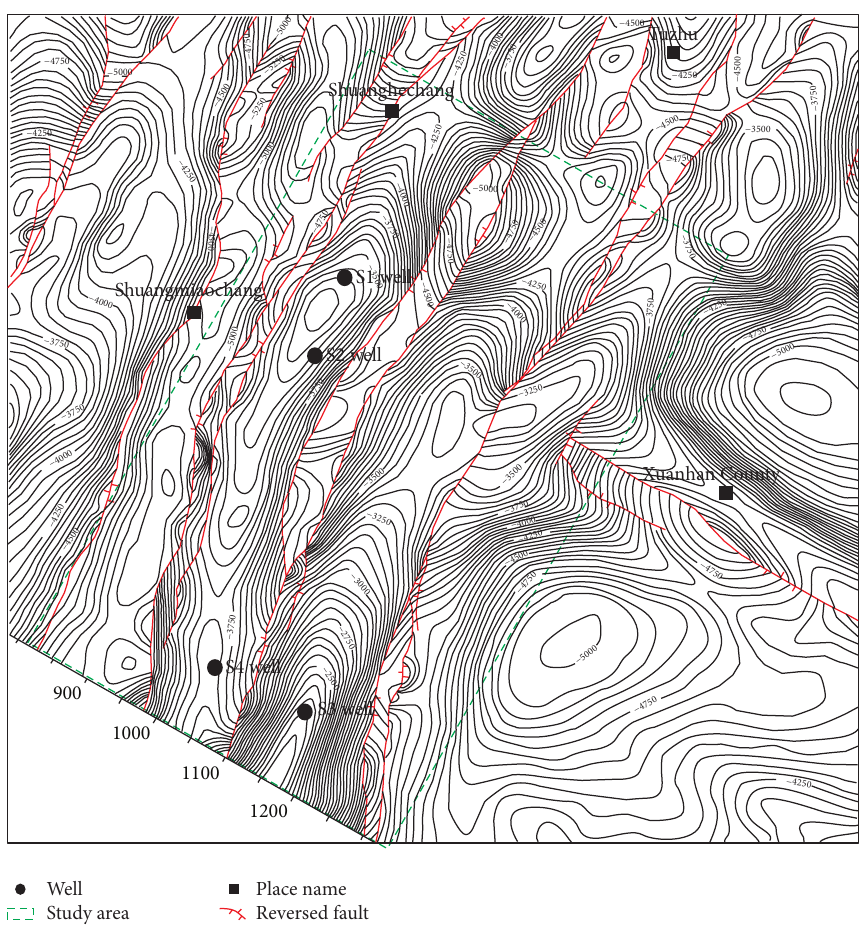
Figure 1: The Jia-2 formation of the top surface structure of the study area.